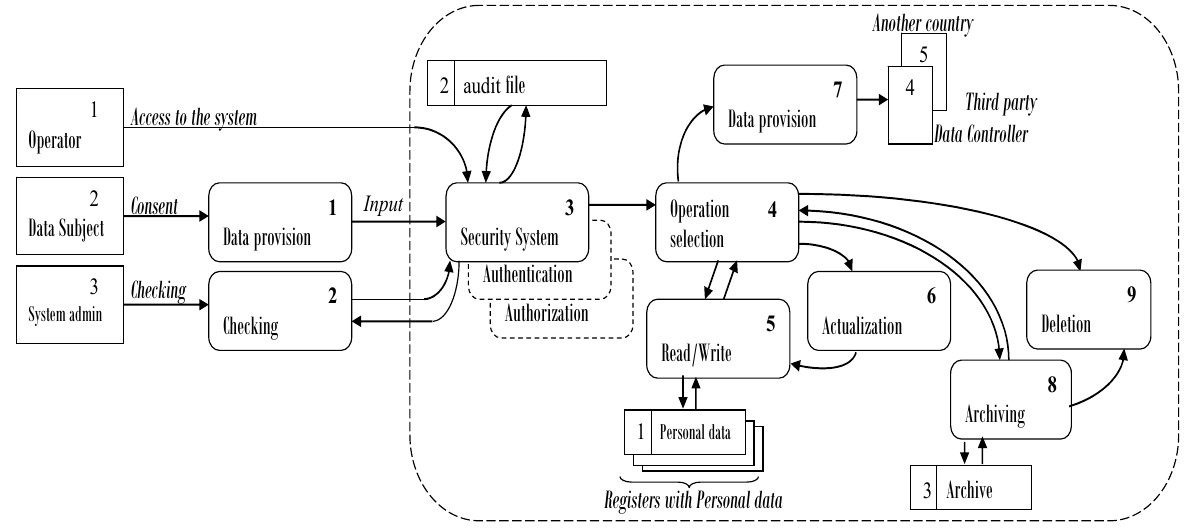
Figure 1. Formalization of personal data processing using a Data Flow Diagram (DFD).